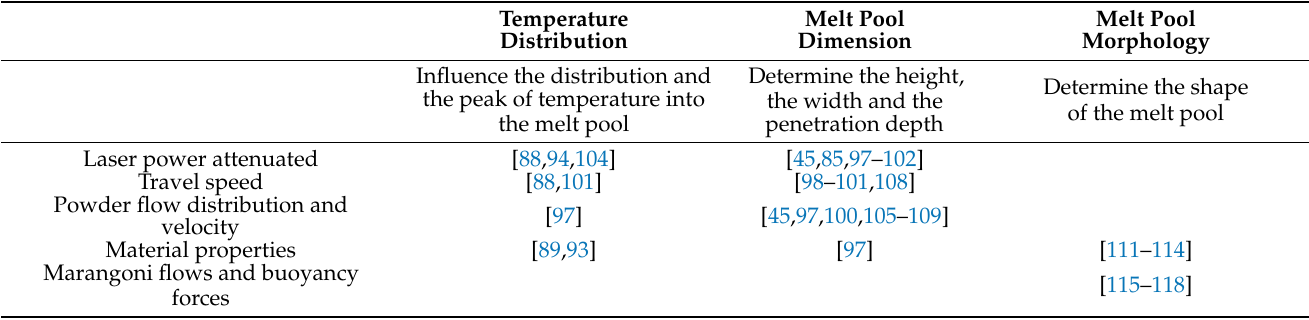
Table 4. Summary of the factors influencing the melt pool generation mechanisms. Temperature